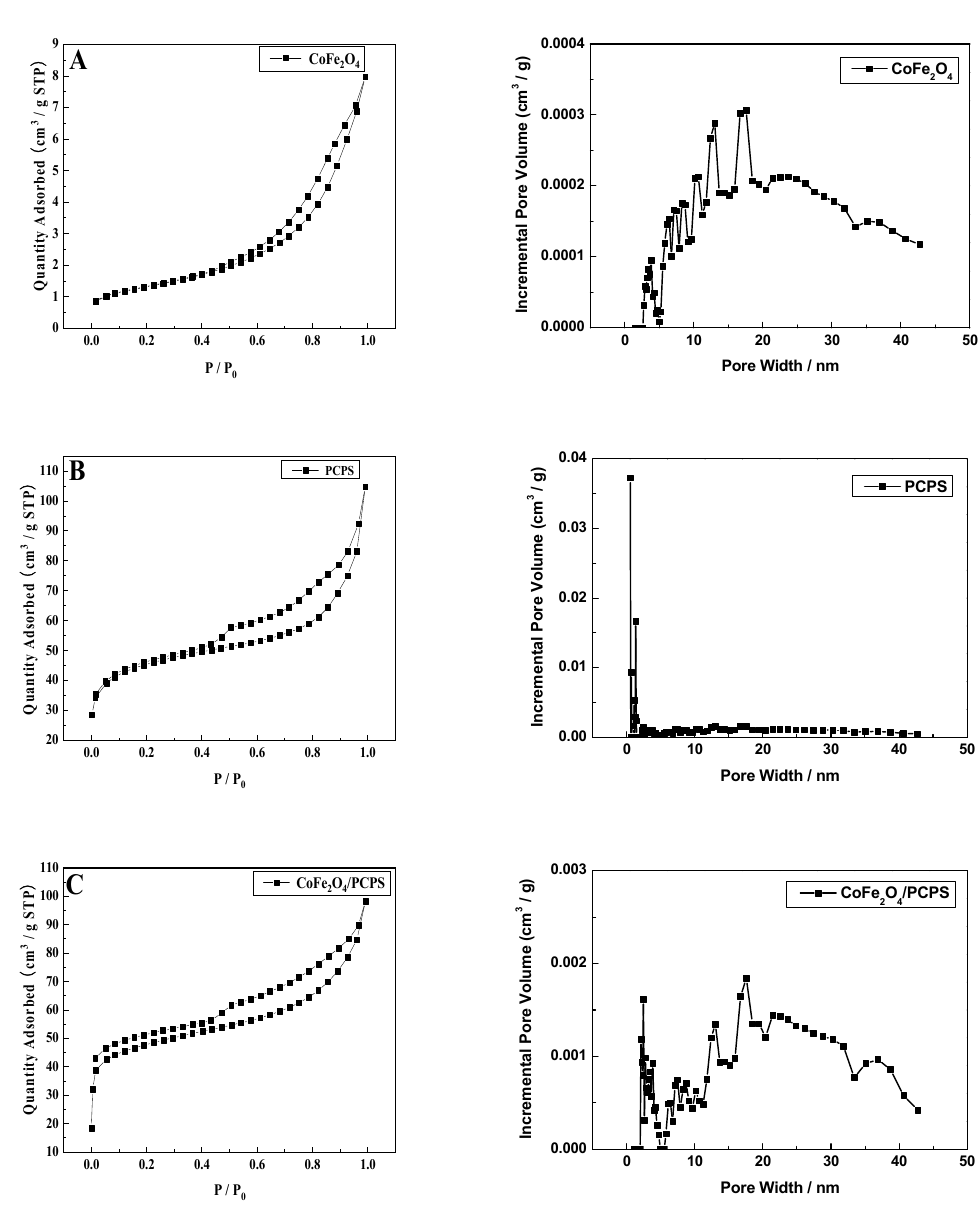
Figure 6. N 2 adsorption–desorption isotherms and the pore size distribution of the CoFe 2 O 4 ( A ), PCPS ( B ), and CoFe 2 O 4 /PCPS ( C ).